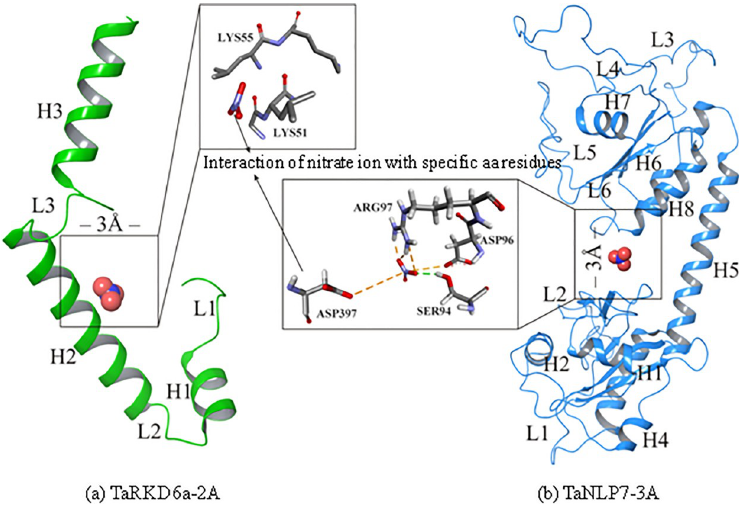
Fig 6. Interaction of nitrate ion with specific amino acid residues of (a) TaRKD6-2A and (b) TaNLP3-7A proteins.